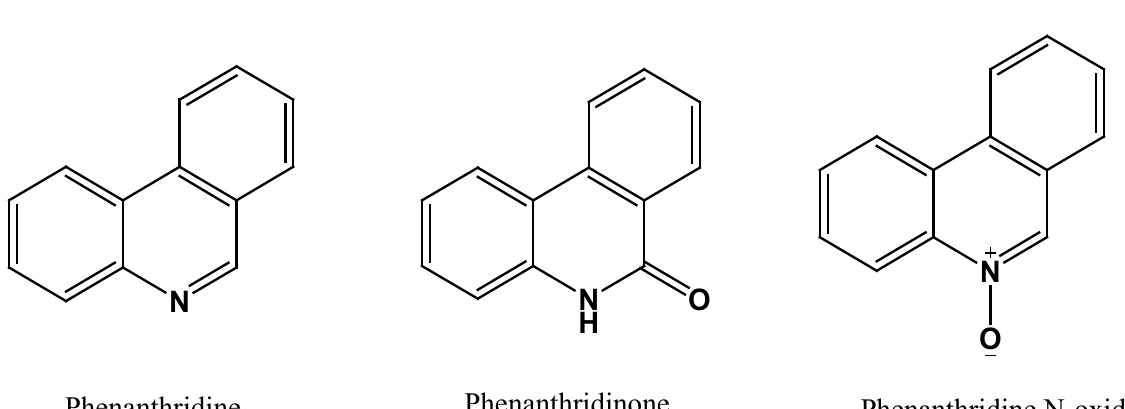
Figure 1. The structure of phenanthridine, phenanthridinone and phenanthridine